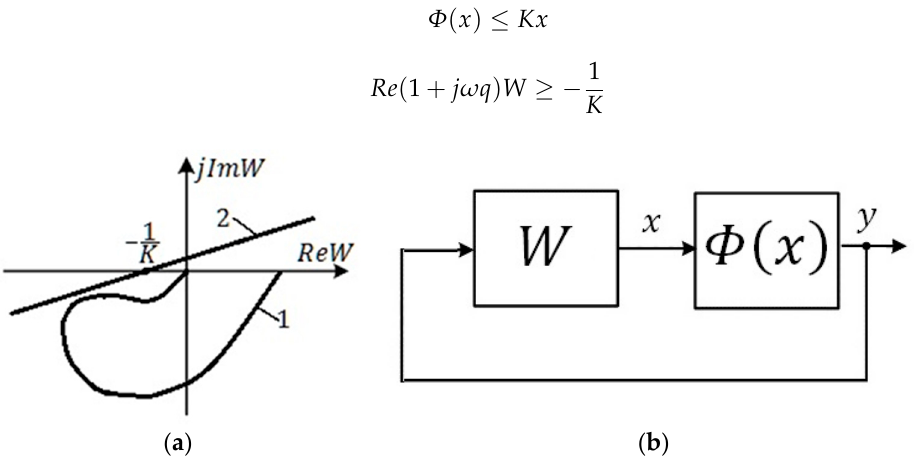
Figure 3. Stability criterion for LFC ACS.